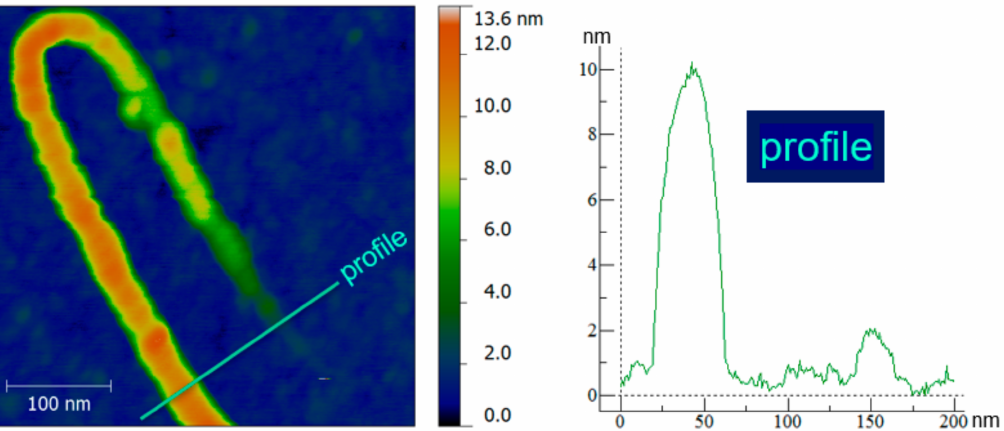
Figure 14. AFM analysis of ultrathin electrospun ovalbumin. Courtesy of Dr. A. Eleta Dr. W. Nuansing, CIC